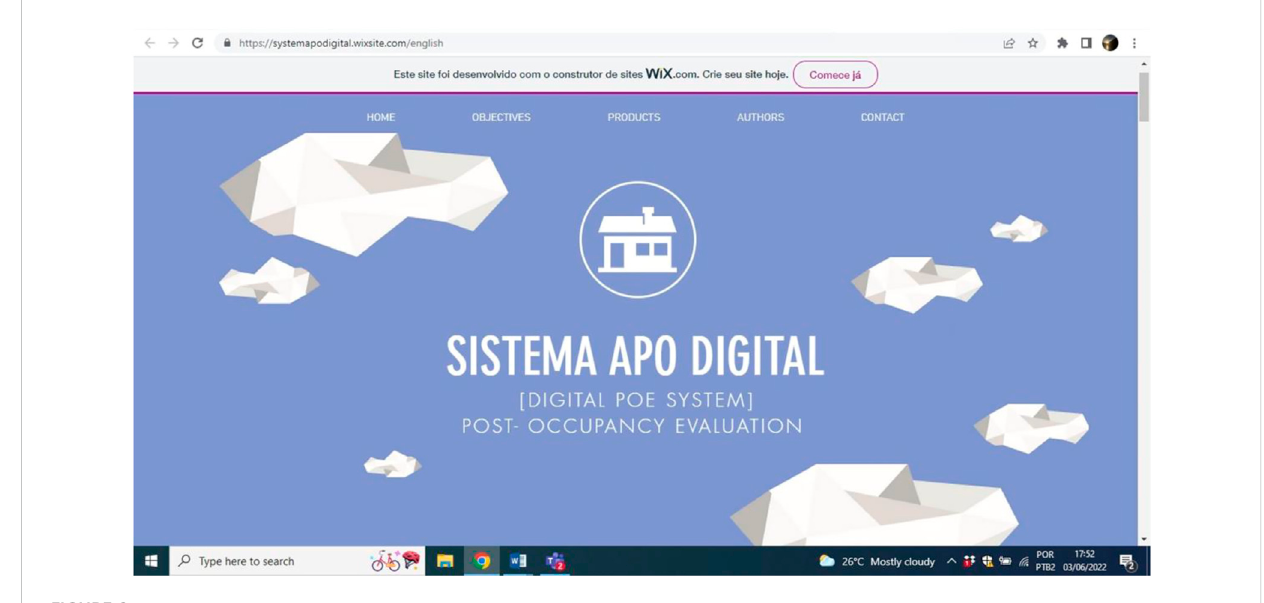
FIGURE 2 Mora App 1 —